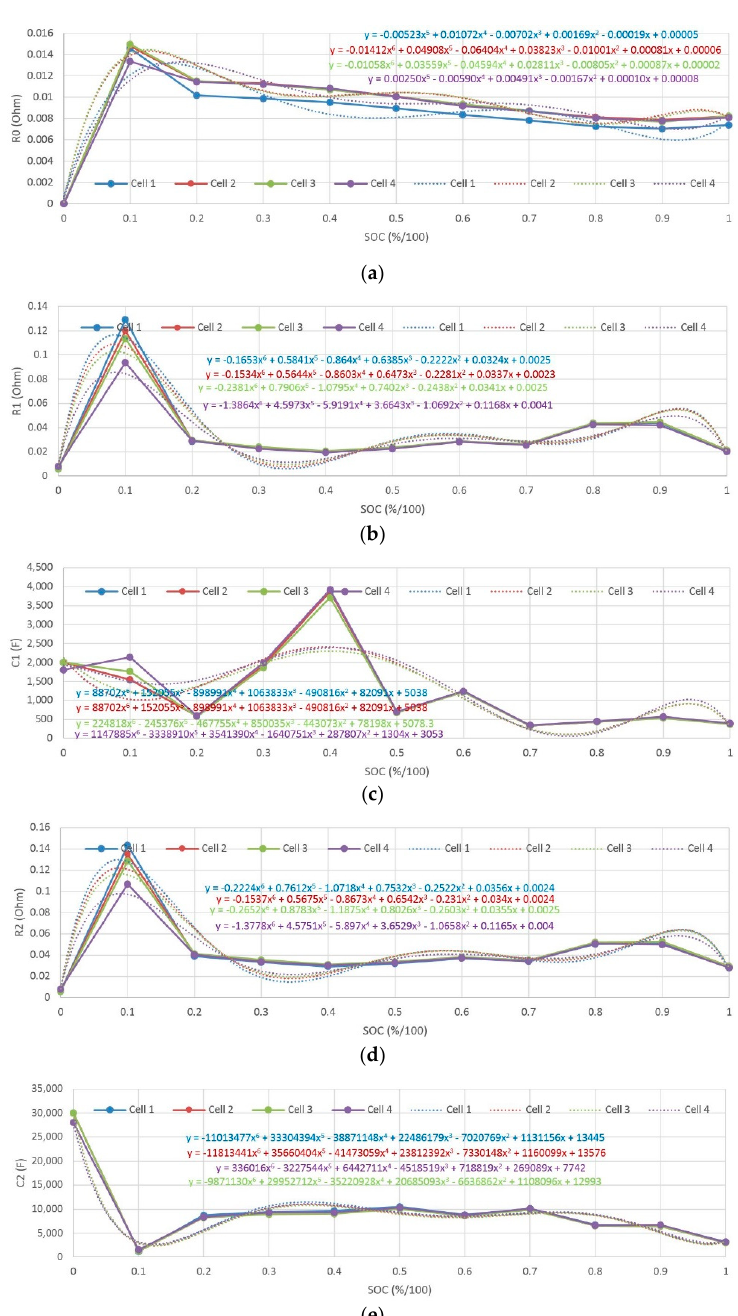
Figure 3. Extracted parameters of the Li–Po battery pack: ( a ) R 0 , ( b ) R 1 , ( c ) C 1 , ( d ) R 2 , and ( e ) C 2